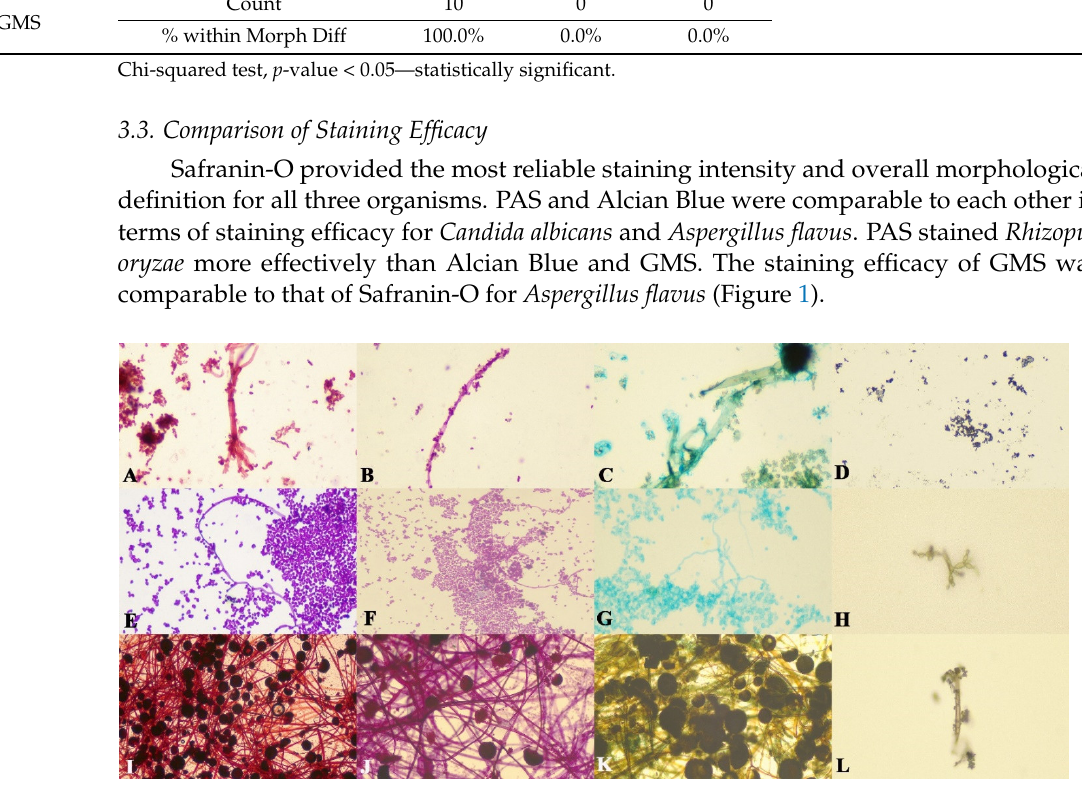
Figure 1. Photomicrographs of Aspergillus flavus showing: ( A ) branching hyphae and spores (×100 magnification, Safranin-O); ( B ) hyphae and spores (×100 magnification, PAS stain); ( C ) hyphae, spores and fruiting body (×100 magnification, Alcian Blue stain); ( D ) spores (×100 magnification, GMS stain). Candida albicans showing ( E ) spores, hyphae and germ tube formation (×100 magnification, Safranin-O); ( F ) hyphae and spores (×100 magnification, PAS stain); ( G ) hyphae and spores (×100 magnification, Alcian Blue stain); ( H ) germ tube formation (×100 magnification, GMS Stain). Rhizopus Oryzae showing ( I ) hyphae and fruiting bodies (×100 magnification, Safranin-O); ( J ) hyphae and fruiting bodies (×100 magnification, PAS stain); ( K ) hyphae and fruiting bodies (×100 magnification, Alcian Blue stain); ( L ) hyphae and spores (×100 magnification, GMS stain).